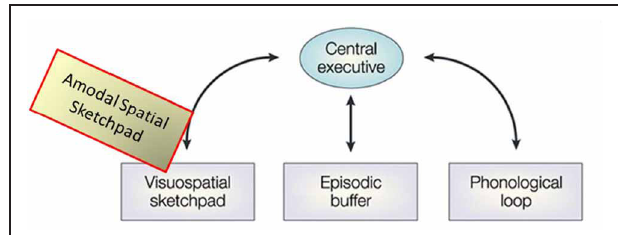
FIGURE 11 | Re-conceptualization of the visuo-spatial sketchpad as an amodal-spatial sketchpad. Modified schematic of the main modules of Baddeley’s classic model of working memory including the visuo-spatial sketchpad [after Baddeley, 2003], where the added “Amodal-Spatial Sketchpad” block depicts our re-conceptualization of the visuo-spatial sketchpad as being accessible to any sensory modality.